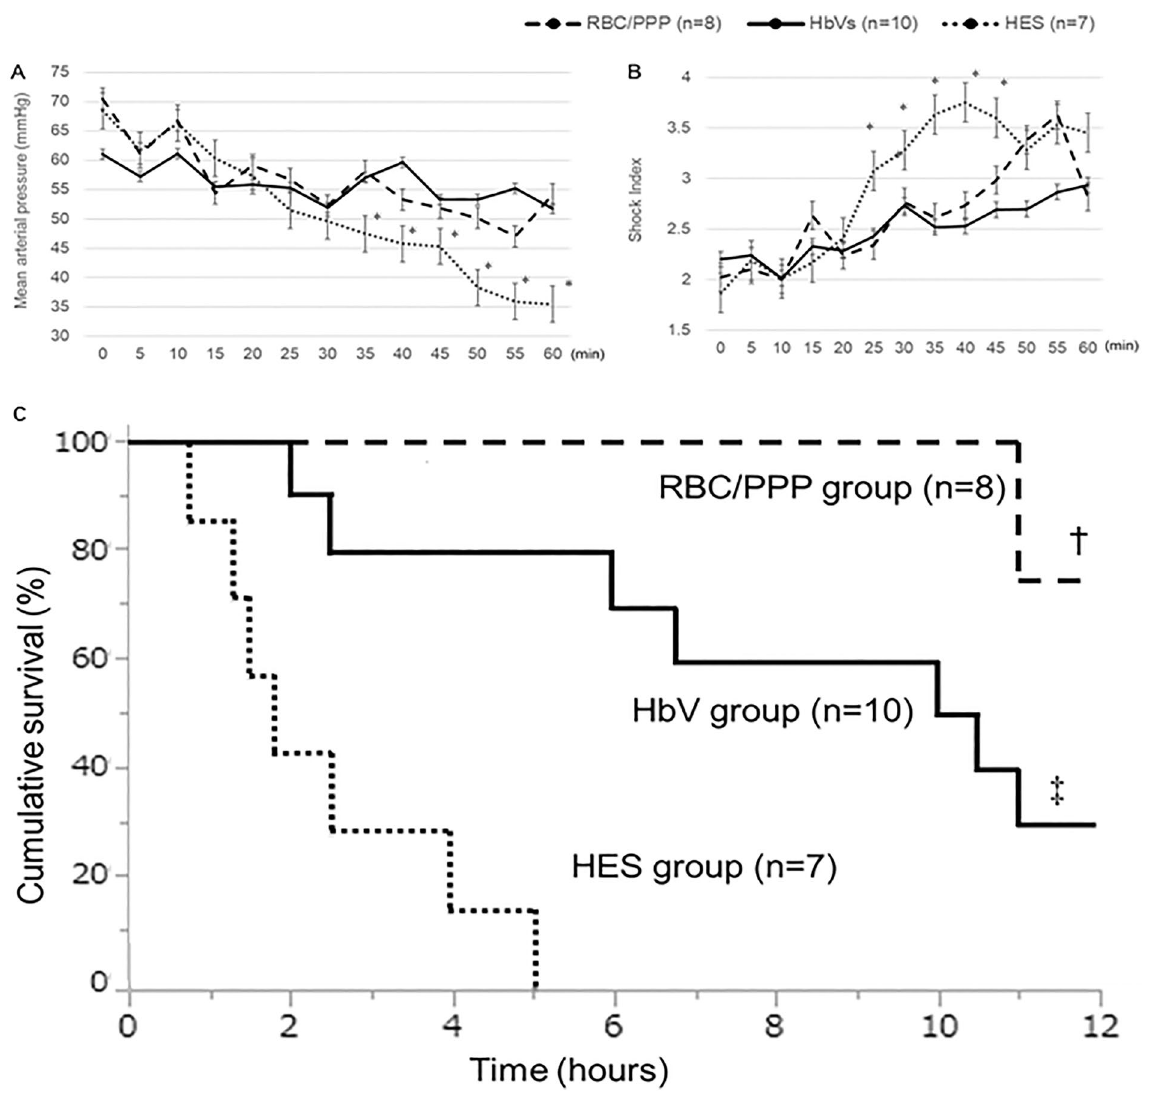
Figure 2. Hemodynamic changes and survival curves of all three groups. ( A ) The HES group shows progressively decreased MAP after 30 min, and the values are significantly lower than in the other groups. ( B ) In the HES group, the shock index from 25 to 45 min is significantly higher than in the other groups, whereas there is no significant difference at 60 min. ( C ) Survival of the HbV group is significantly better than that of the HES group (P < 0.01), whereas it is significantly worse than that of the RBC/PPP group (P = 0.01). *P < 0.05, value significantly different from the other groups. † P < 0.05, the prognosis of the RBC/PPP group is significantly different from that of the other groups. ‡ P < 0.05, the prognosis of the HbV group is significantly different from that of the HES group. Data shown are the mean ± standard deviation. HbV hemoglobin vesicles, HES hydroxyethyl starch, MAP mean arterial pressure, RBC/PPP red blood cells with platelet-poor − level and biochemical status. The HbV group did not show a signifi- Changes in the plasma NO 2 cant reduction in NO 2− levels (Table 4). HbV infusion did not induce hemolytic and acute renal dysfunction as indicated by the values of iron and creatinine being maintained within normal ranges. In addition, there was no significant increase in free Hb levels (Fig. 6A, Table 4). Meanwhile, although the cell-free heme levels were higher at 60 min after RBC transfusion or HbV infusion than at baseline, the increase in cell-free heme at 60 min was significantly lower in HbV infusion than in RBC transfusion (P < 0.05) (Fig. 6B). Fetus survival after postpartum hemorrhage. The survival rates of the fetuses after PPH in the left side of the bicornate uterus was 38 ± 42%, 56 ± 49%, and 79 ± 40% in the HES, HbV, and RBC/PPP groups, respectively. There were no significant differences in survival rates among the three groups.